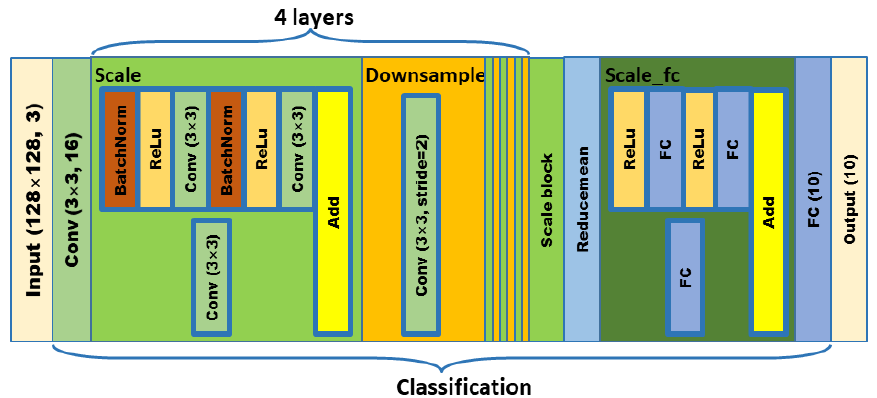
Figure 13. Structure of the classification network. Table 8. Classification accuracy of the c lassification network trained with the expanded training set generated by different generative